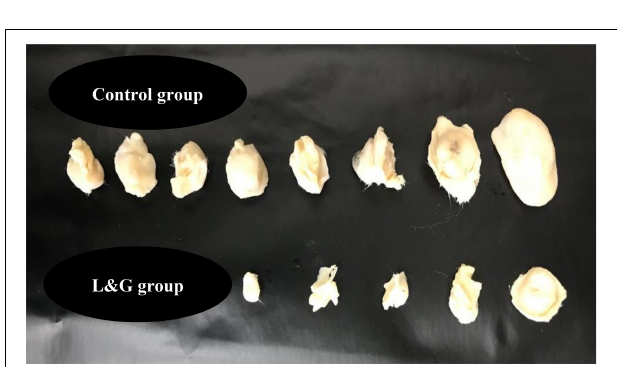
FIGURE 8 | The effect of lemon and ginger combination water extract (L & G) on tumor size and cure percentage. Combination therapy resulted in a high cure percentage and small tumors size. There were 10 mice in each